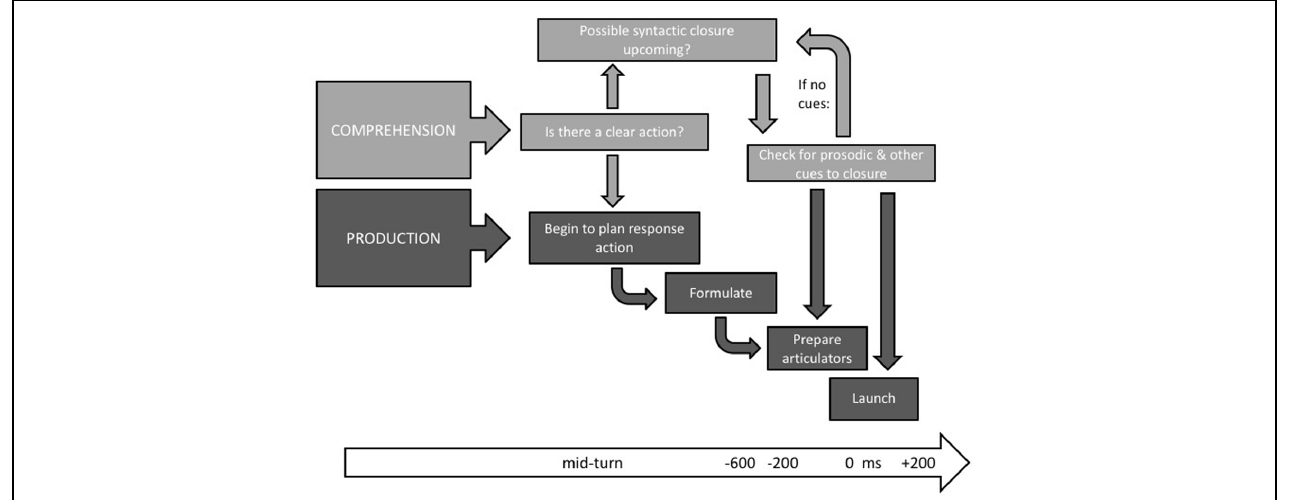
FIGURE 3 | Sketch of the interleaving of comprehension and production in the recipient of an incoming turn.